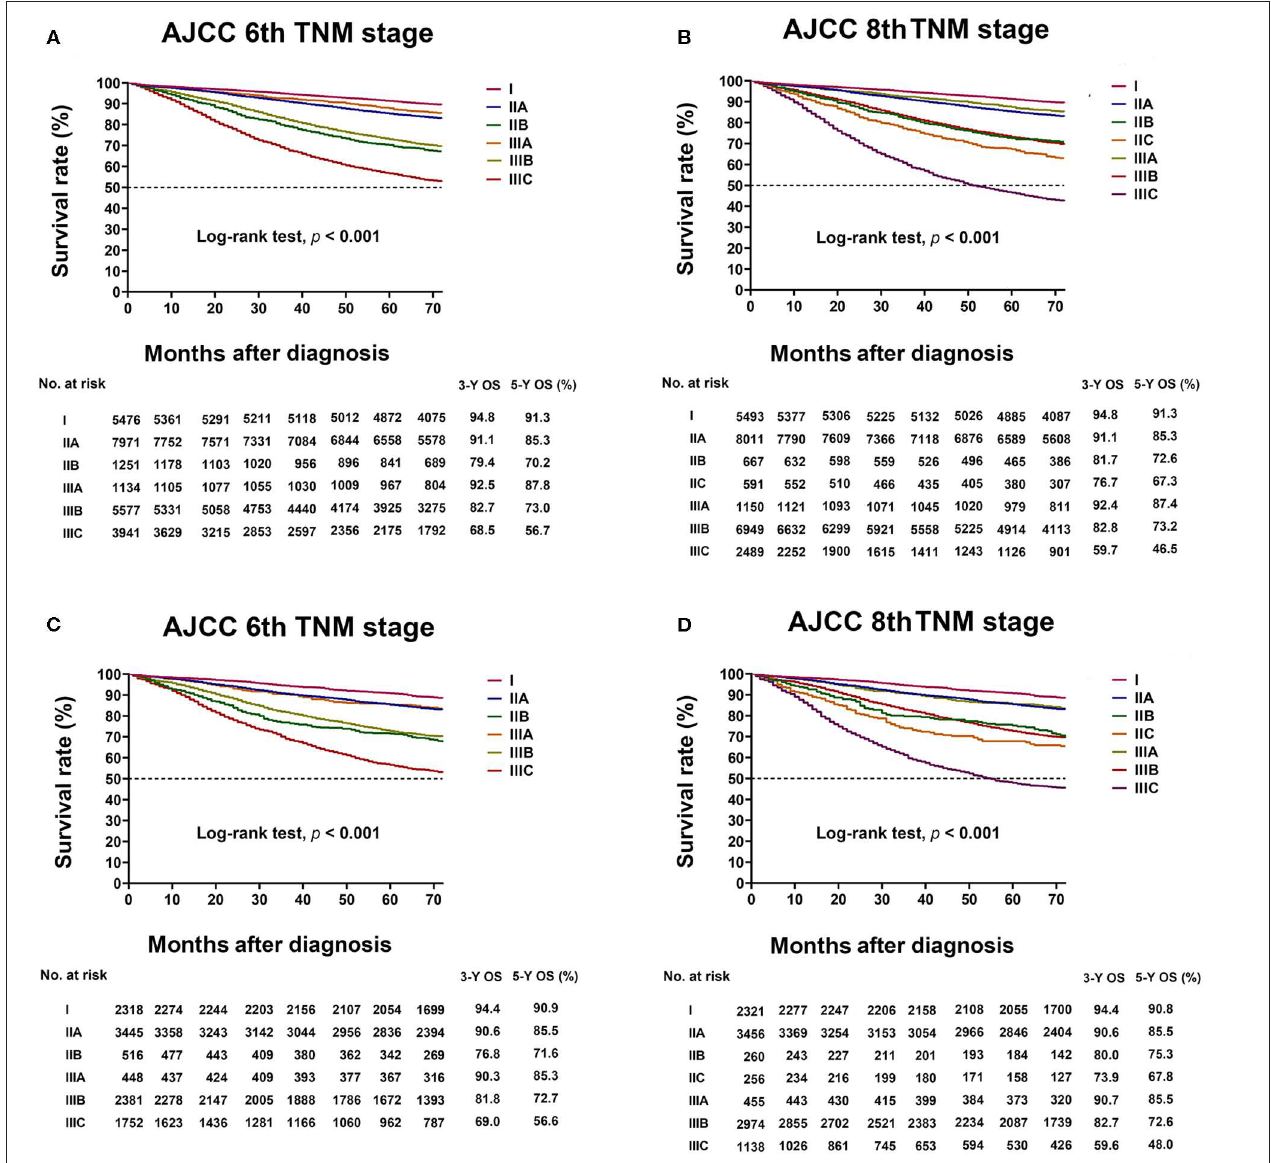
FIGURE 3 | Kaplan–Meier survival curve based on the AJCC 6th TNM and AJCC 8th TNM classifications. (A) Kaplan–Meier survival curves based on AJCC 6th TNM classification in the training cohort. (B) Kaplan–Meier survival curves based on AJCC 8th TNM classification in the training cohort. (C) Kaplan–Meier survival curves based on AJCC 6th TNM classification in the validation cohort. (D) Kaplan–Meier survival curves based on AJCC 8th TNM classification in the validation